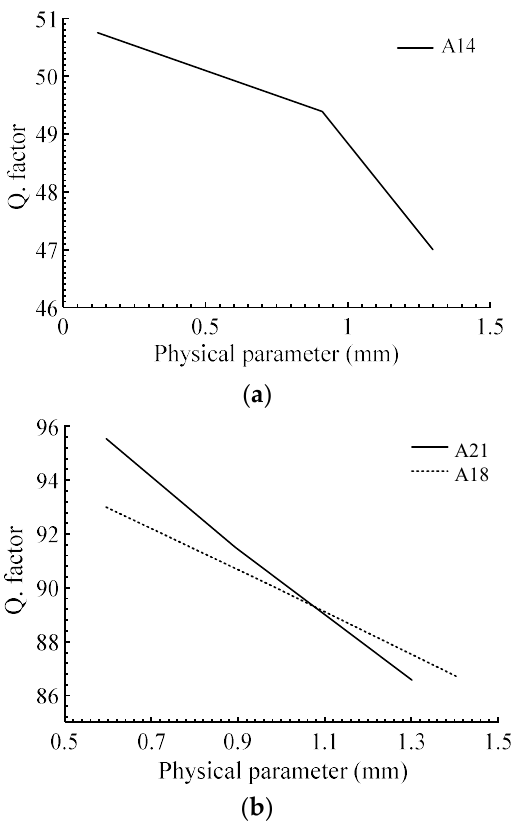
Figure 12. ( a ) Variations of Q. factor versus physical parameters: ( a ) A 14 , ( b ) A 18 and A 21.